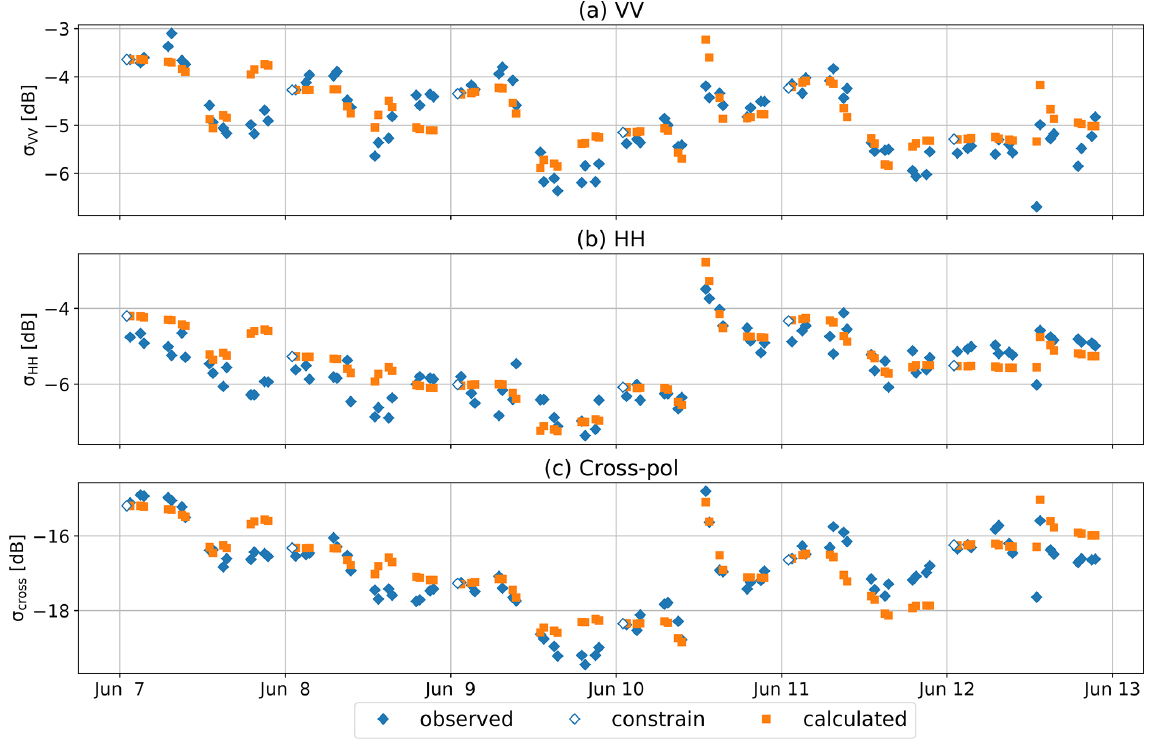
Figure 12. Observed and calculated (a) VV-, (b) HH-, and (c) cross-polarized σ 0 from 7–13 June 2018. The observations which are used to constrain the predictions of sub-daily σ 0 variability, σ 0 t , are accentuated with open markers. Sub-daily backscatter variation is calculated 0 using Eq. (6), the coefficients found by multiple linear regression (Table 2), and the time series of VWC, SCW, and soil